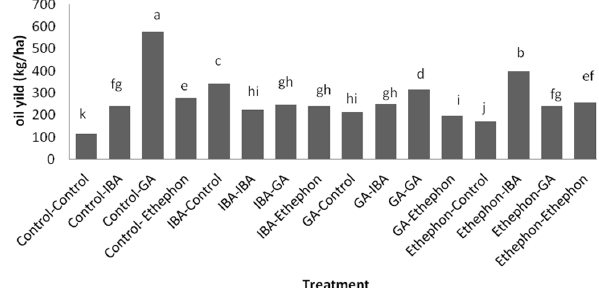
Fig. 6. Effect of PGRs on oil yield kg/ha of medicinal pumpkin ( Cucurbita pepo var . styriaca cv. ‘Kaki’) in trellis